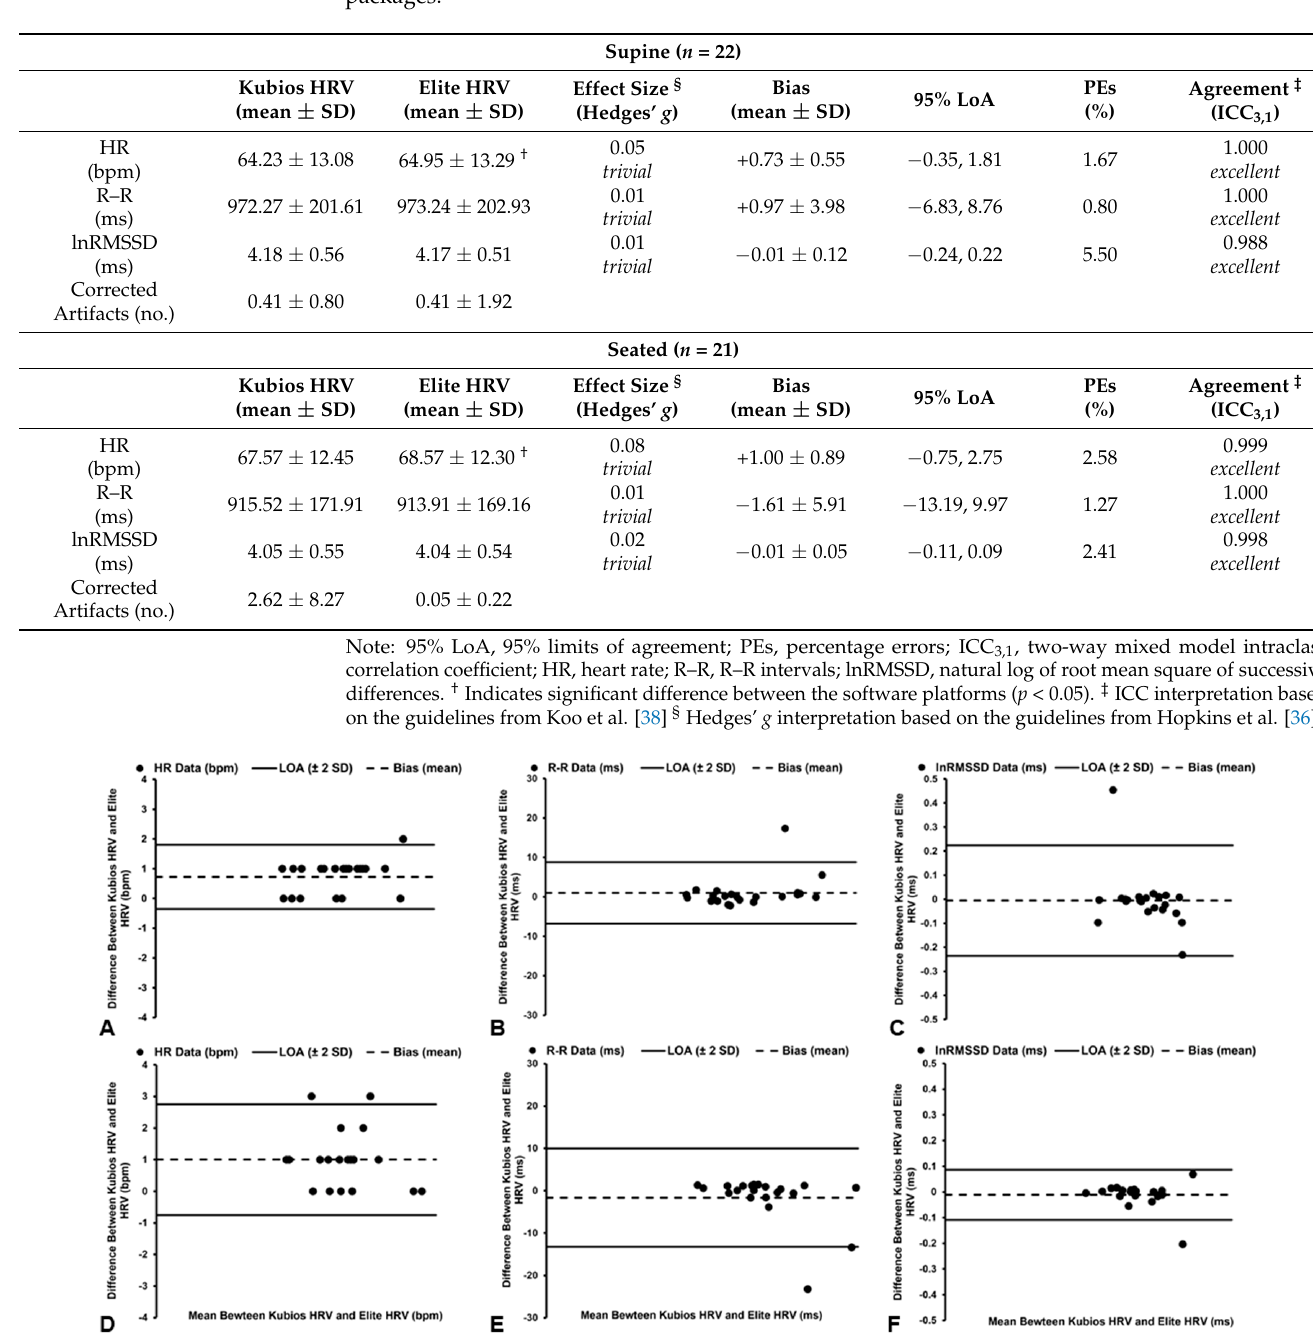
Table 3. Low Correction Level—Descriptive data, bias, error, and agreement between software packages.